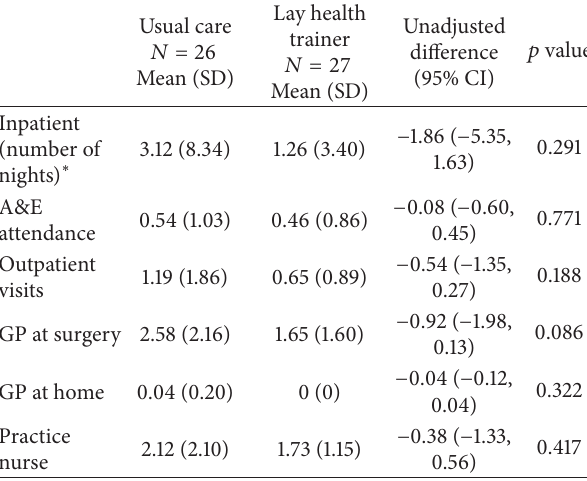
Table 4: Resource use by group (number of contacts) at 7 months based on complete